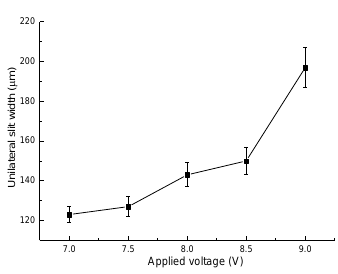
Figure 8. Variation of the unilateral slit width with applied voltage.